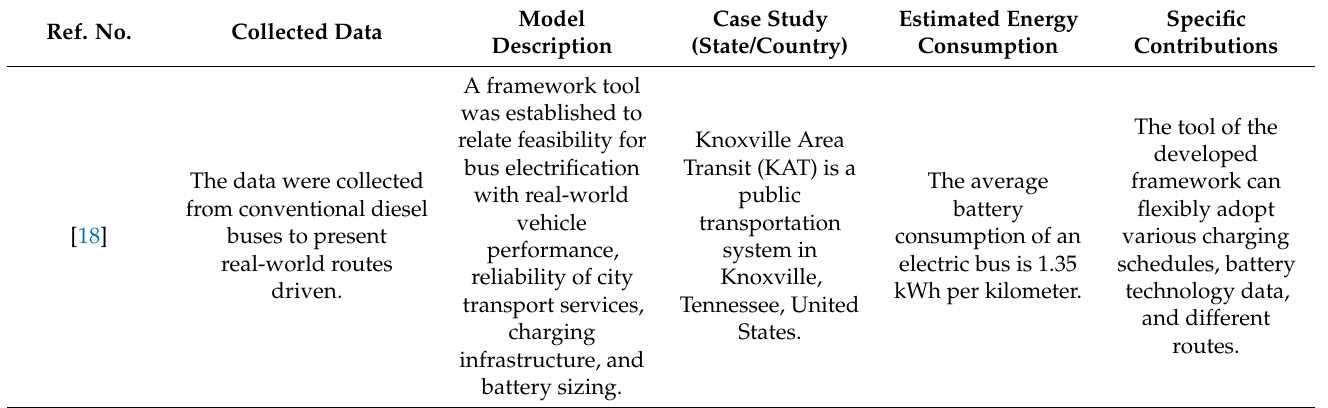
Table 2. Number of actual models according to different countries.